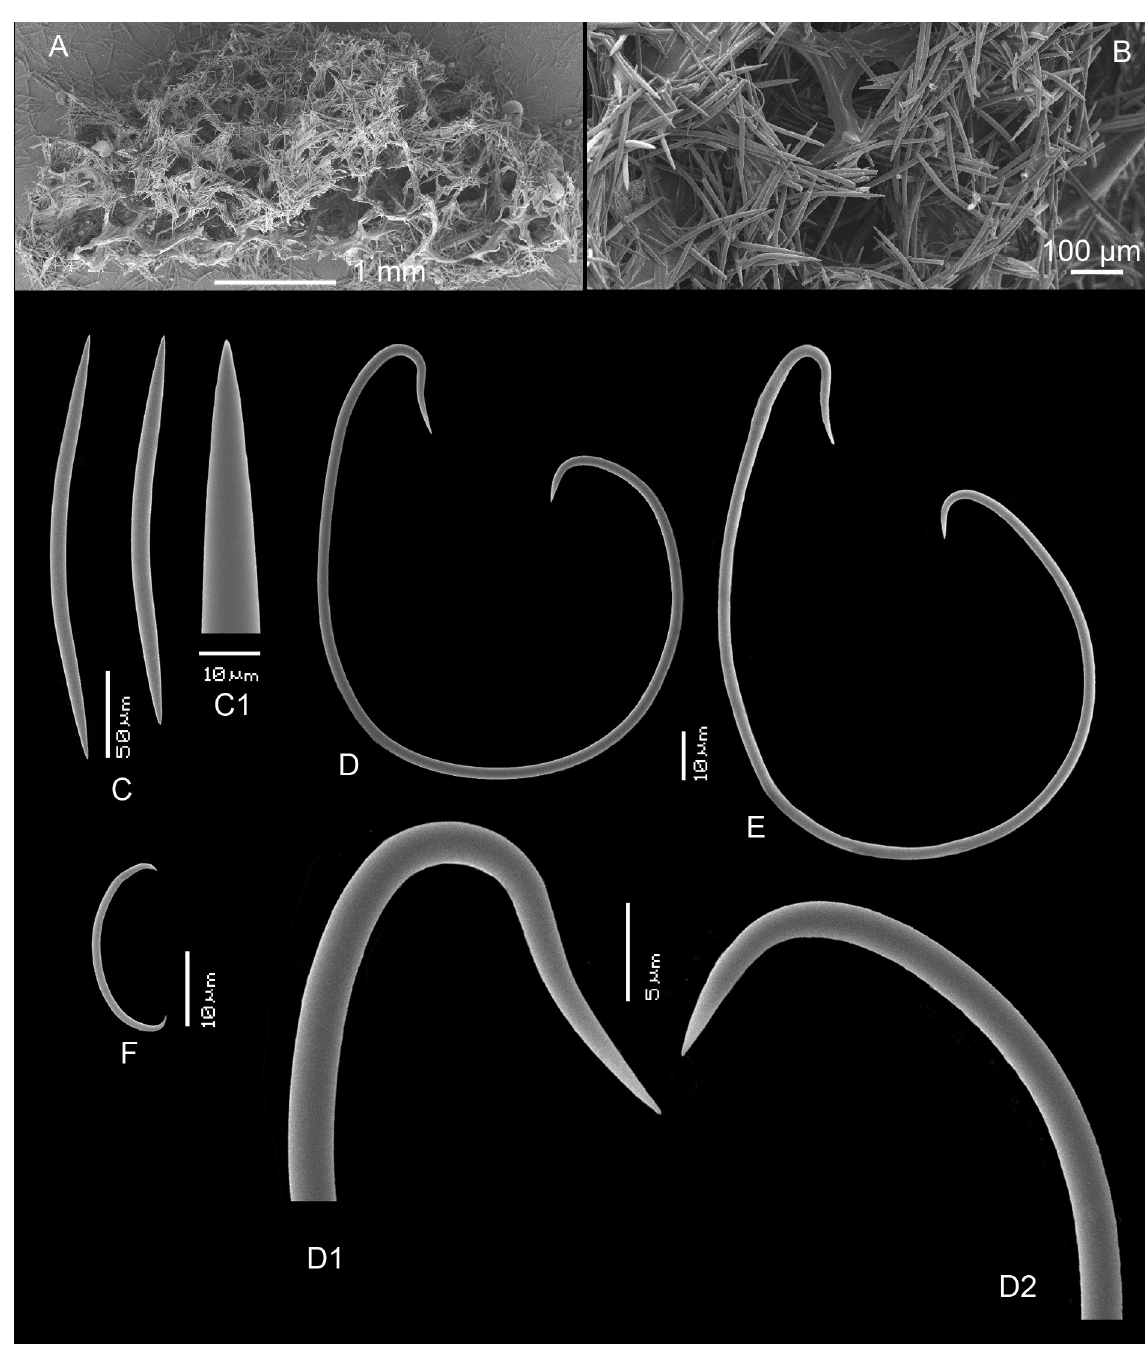
Fig. 5. Haliclona ( Flagellia ) indonesiae subgen. et sp. nov., holotype (RMNH Por. 2326). A . SEM image of cross section. B . SEM image of surface. C–F . SEM images of spicules. C . Oxeas. C of one of the apices. D–E . Flagellosigmas. D ending of flagellosigma. F .